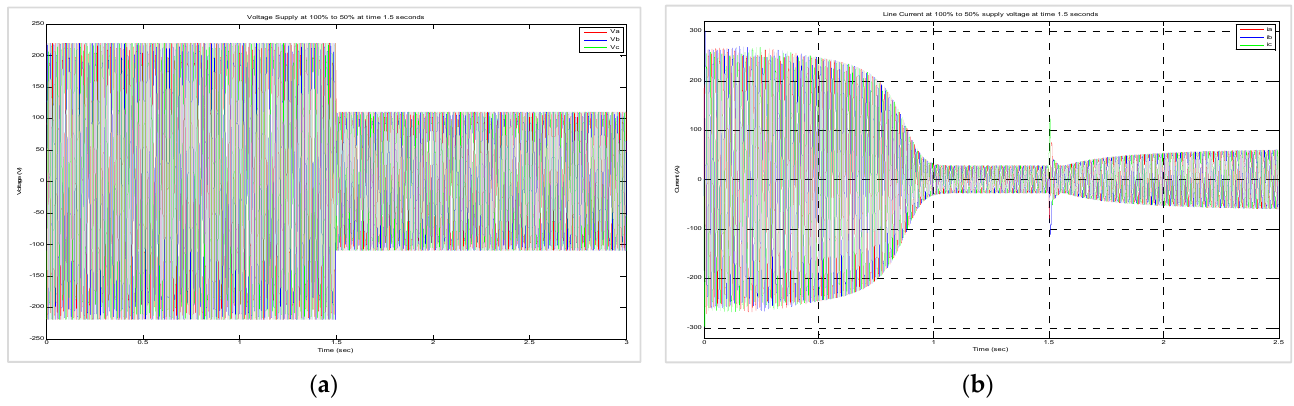
Figure 24. Speed at 50% to 100% loading at 1 s.